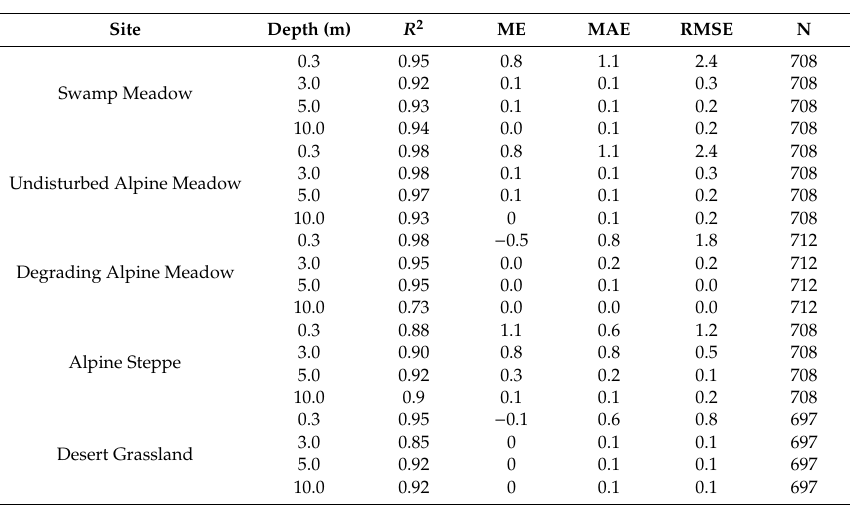
Table 3. Statistics of the measured and simulated mean annual ground temperature (MAGT) at di ff erent depths. ME = mean error; MAE = mean absolute error; RMSE = root mean square error; R 2 = coe ffi cient of determination; N =